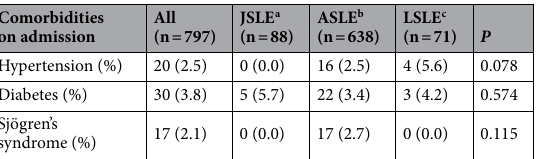
Table 2. Common comorbidities occurred in patients from each age-onset group. a JSLE juvenile-onset SLE; b ASLE adult-onset SLE; c LSLE late-onset SLE.